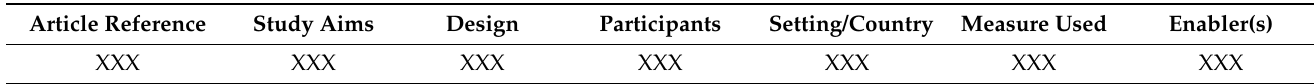
Table A2. Data Extraction Template.